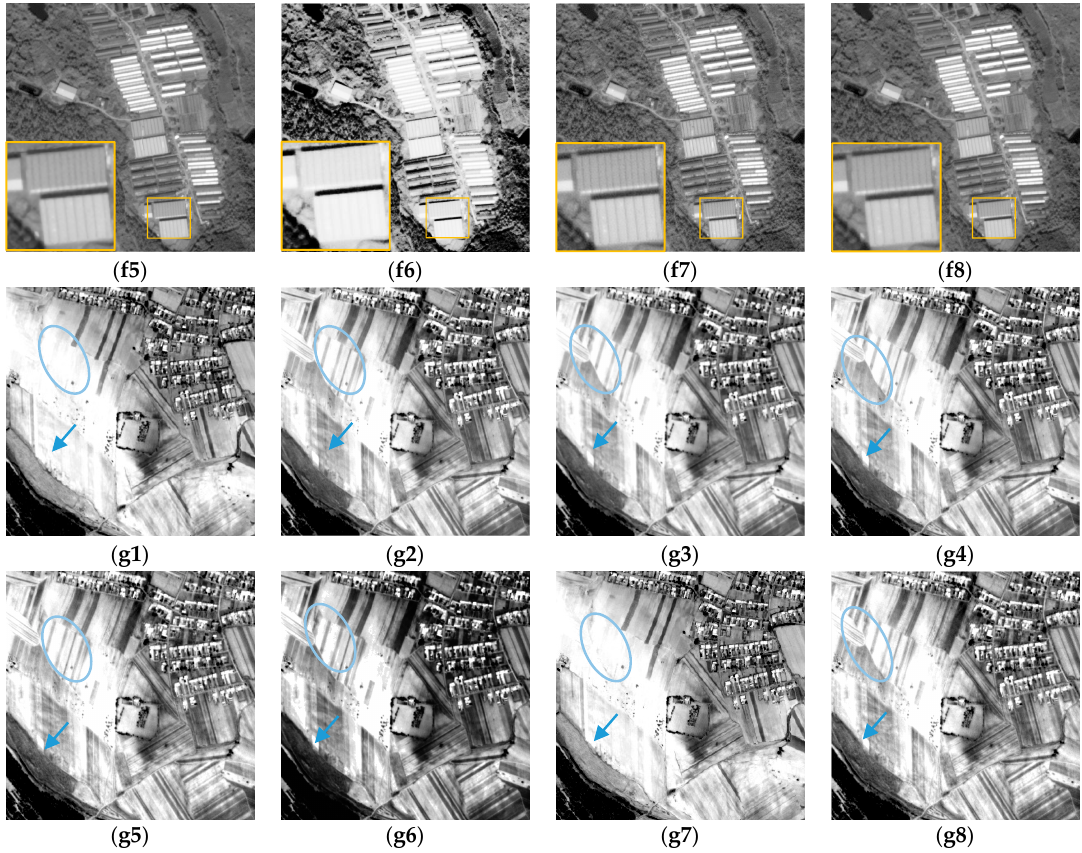
Figure 8. Reconstructed HR images of different areas by different super resolution